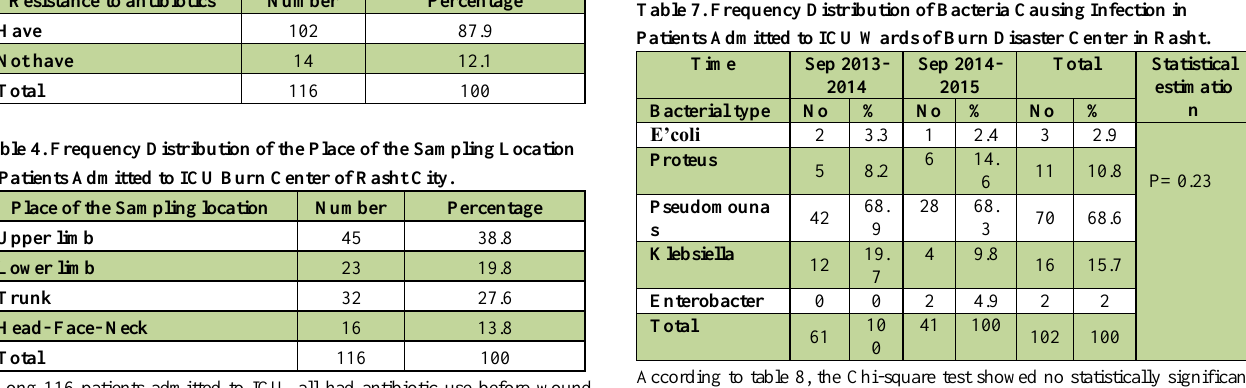
Table 7. Frequency Distribution of Bacteria Causing Infection